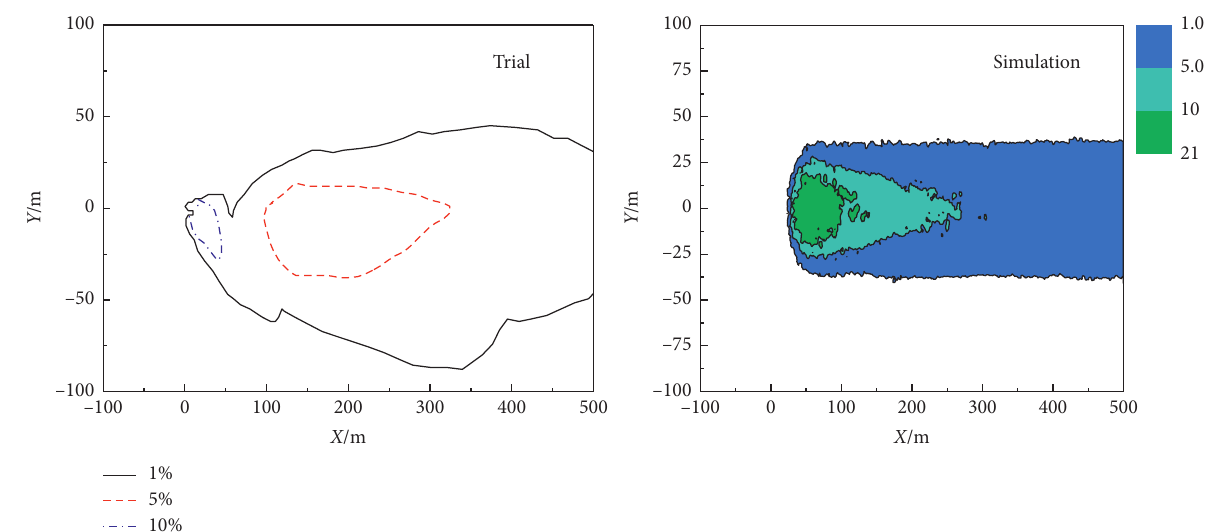
Figure 5: Comparison of Burro 9 trial and Fluent simulation for LNG horizontal volume-concentration distribution ( Z � 1m and t � 80